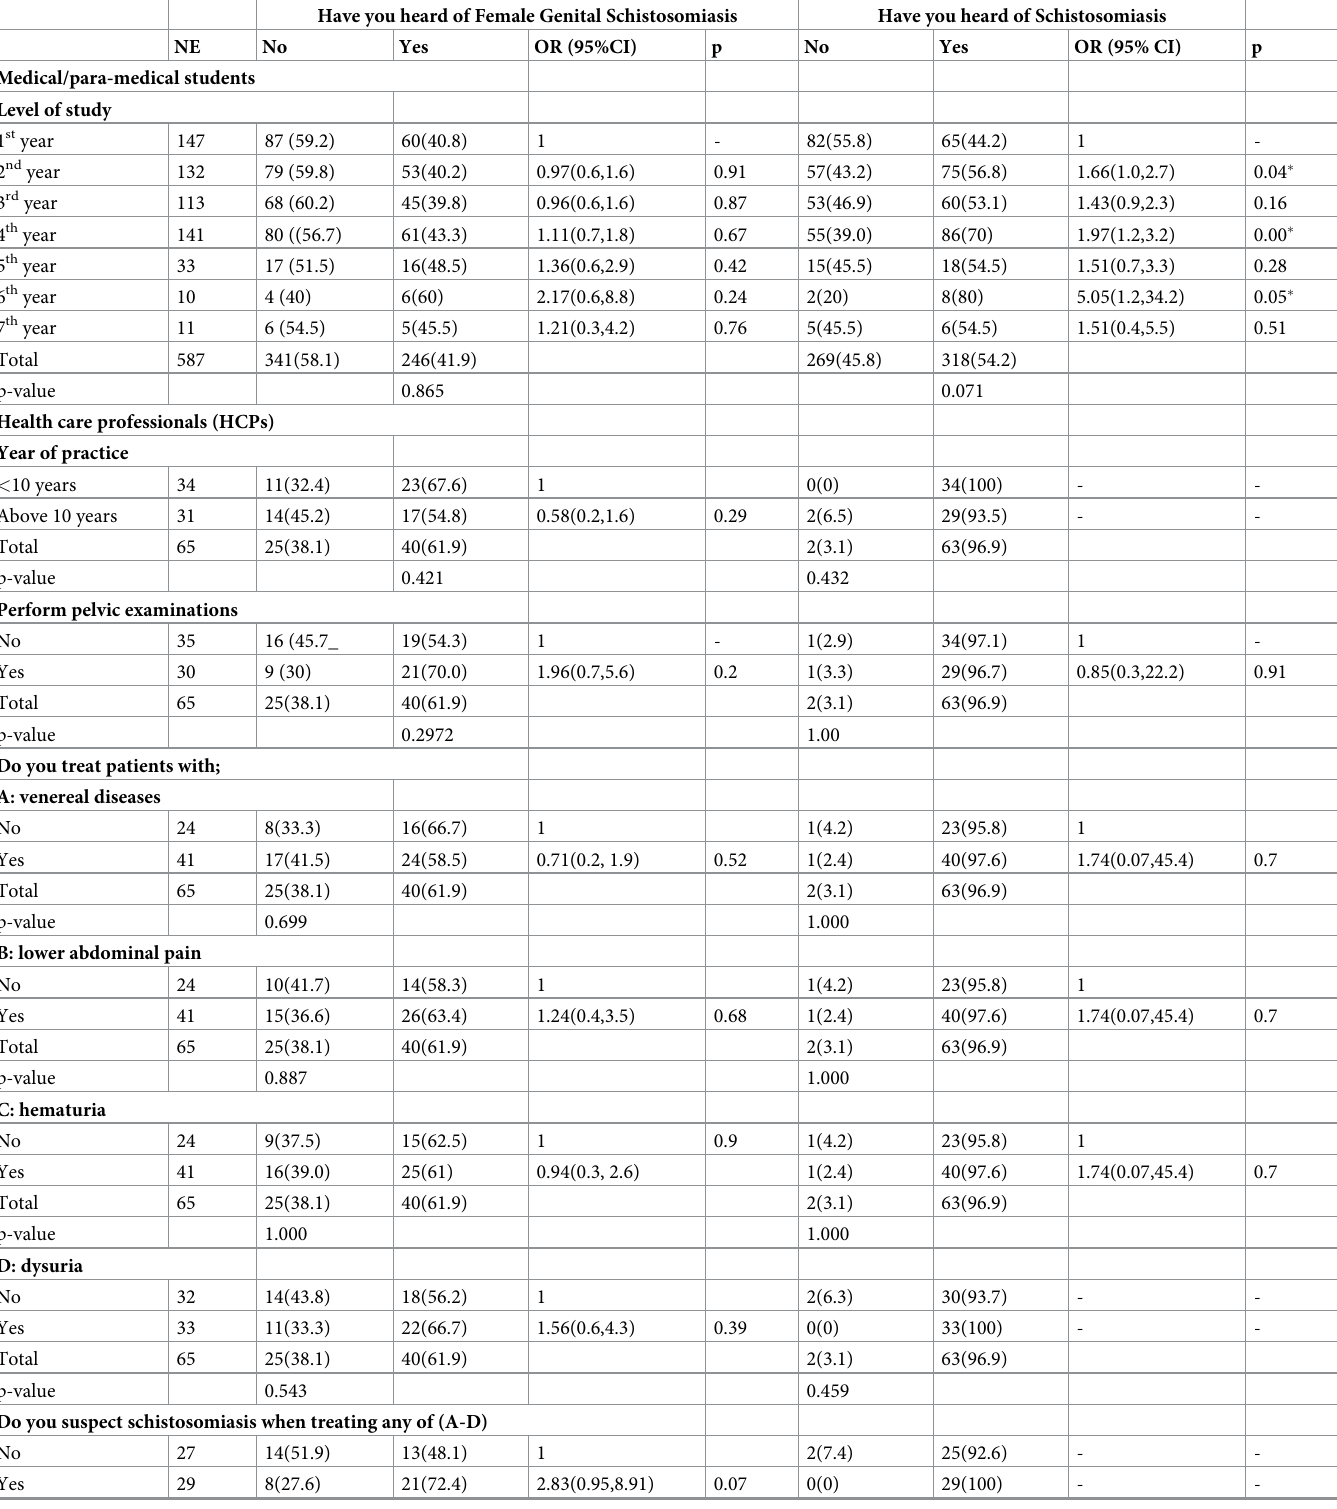
Table 2. Regression analysis between knowledge of study participants, students’ year of study, and expertise of health care